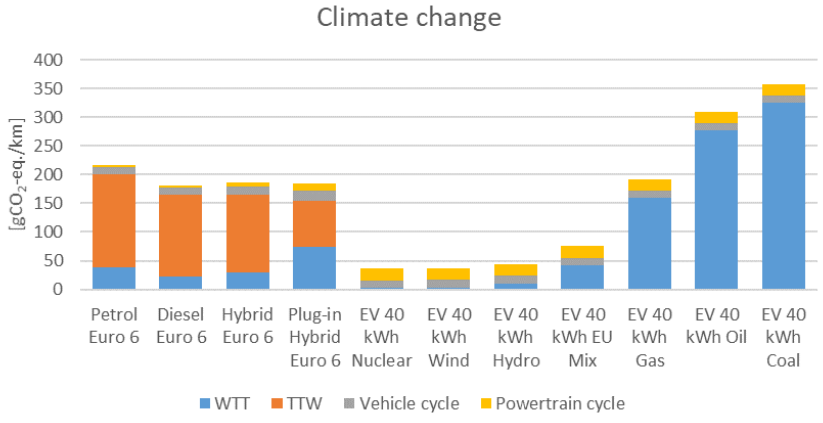
Figure 11. Impact of the energy production mix in grams per kilometer (based on 46).